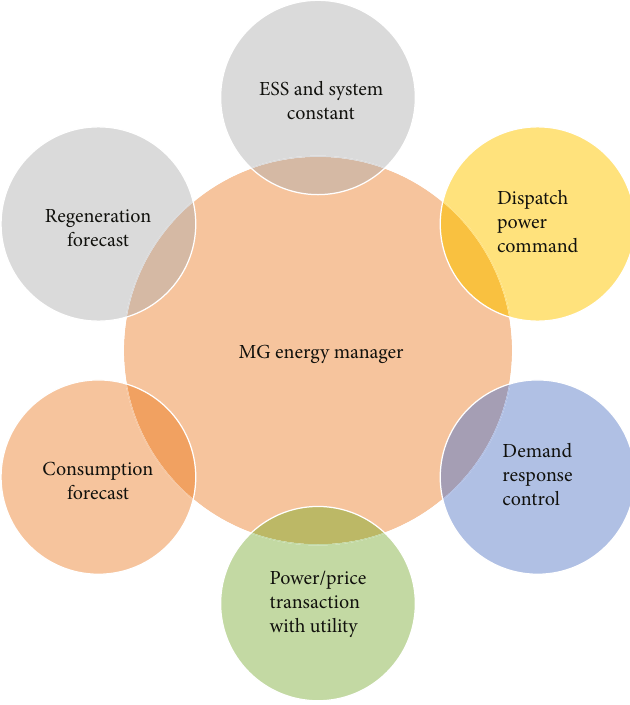
Figure 1: Microgrid energy